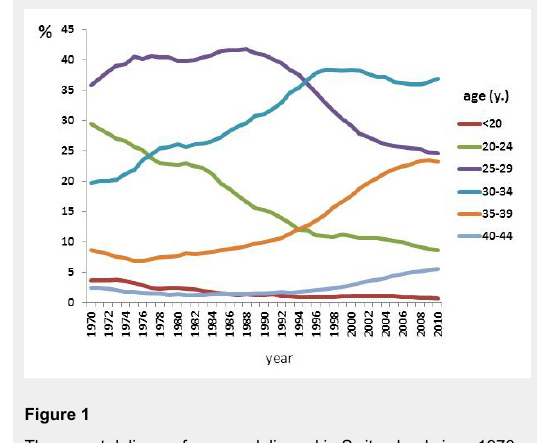
The age at delivery of women delivered in Switzerland since 1970 (Source: BfS; www.bfs.admin.ch). Whereas the number of women giving birth at the age of 30 y or less is on the decline since 1990, the number of older women giving birth is on the rise, in particular those above the age of 35